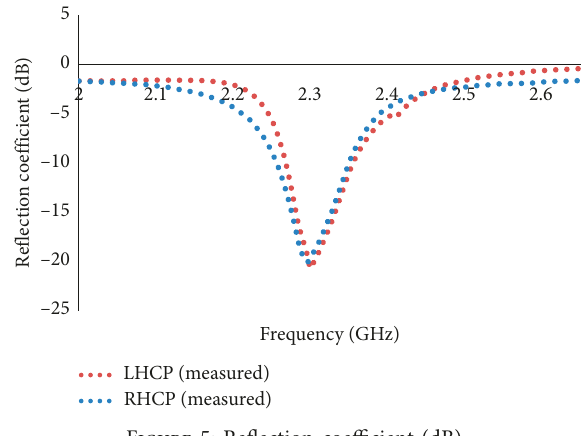
Figure 5: Reflection coefficient